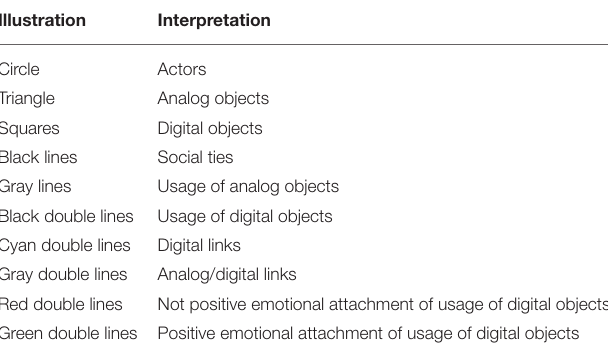
TABLE 4 | Patterns in socio-material networks based on Basov (2018).